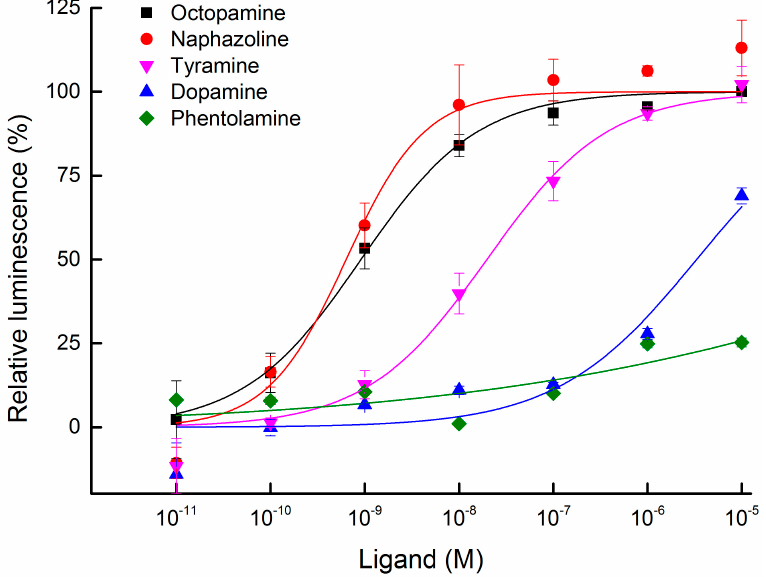
Figure 5. Agonist concentration-response curves of BdOct β R1 transiently expressed in HEK-293 cells to five tested ligands (octopamine, naphazoline, tyramine, dopamine, and phentolamine). Each spot represents the mean relative luminescence ± S.E. from three independent tests and three biological replications per experiment. Each value was normalized to the cAMP luminescence obtained with octopamine at 1 × 10 − 5 M (=100%).